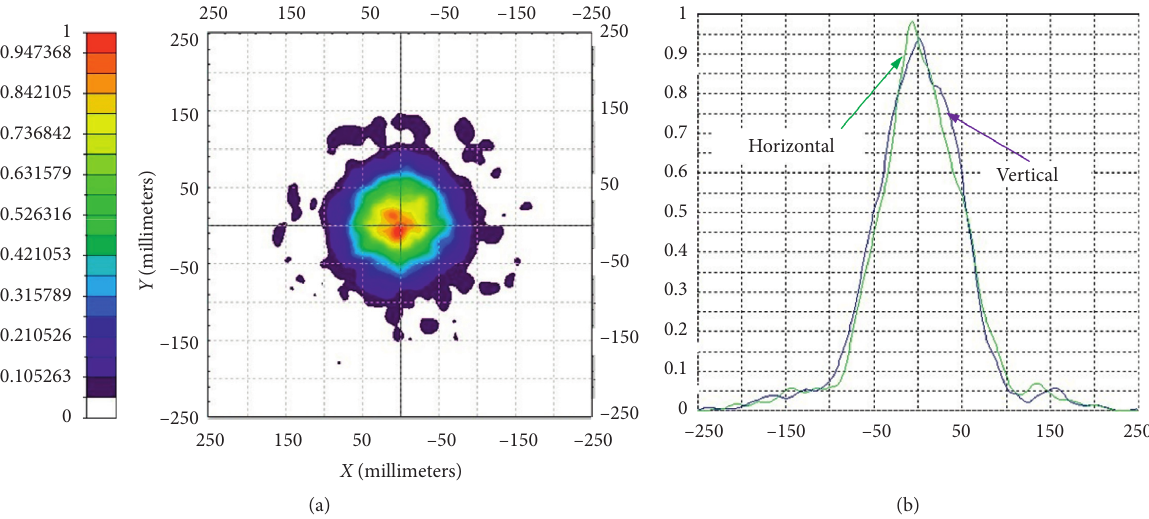
Figure 3: Total-irradiance map diagram of the receiving surface of the sunflower-shaped plano-convex lens